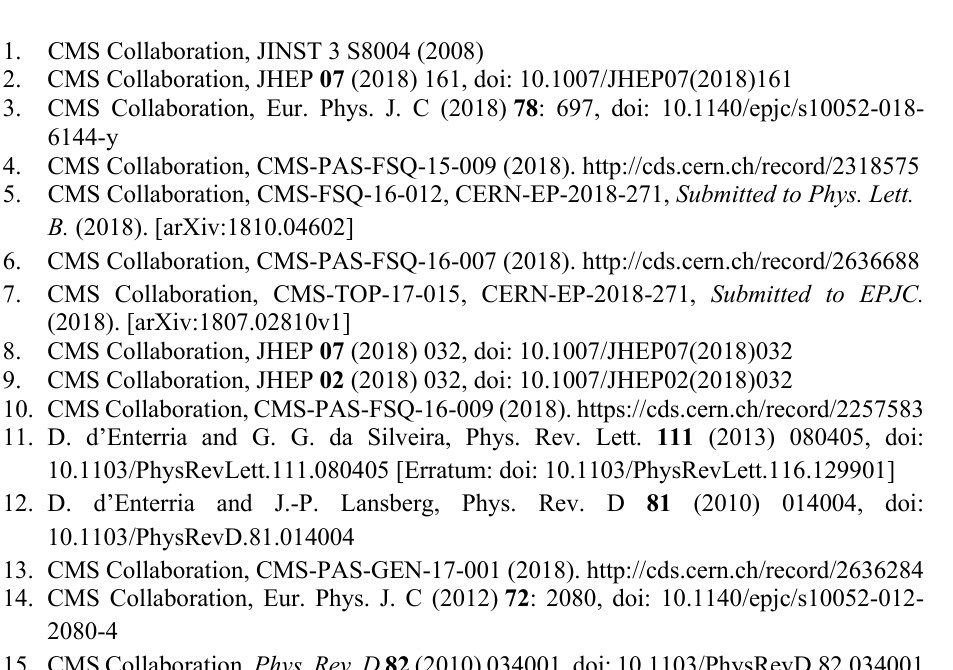
channel at 8 using various processes at the ± ± 𝜇𝜇 𝜇𝜇 𝜎𝜎 𝑜𝑜𝑜𝑜𝑜𝑜